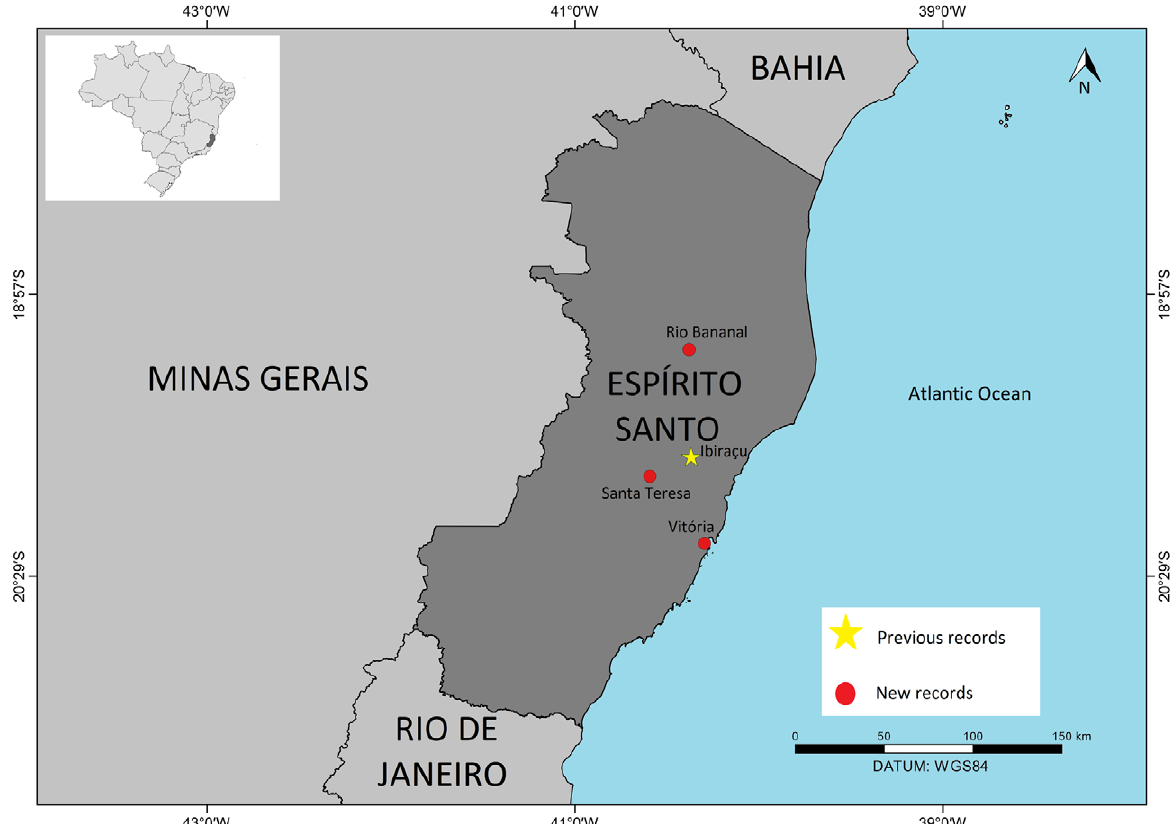
Figure 1. Adult of Neocrex erythrops. A. From Santa Teresa (MBML 7718). B. From Rio Bananal, Espírito Santo state,